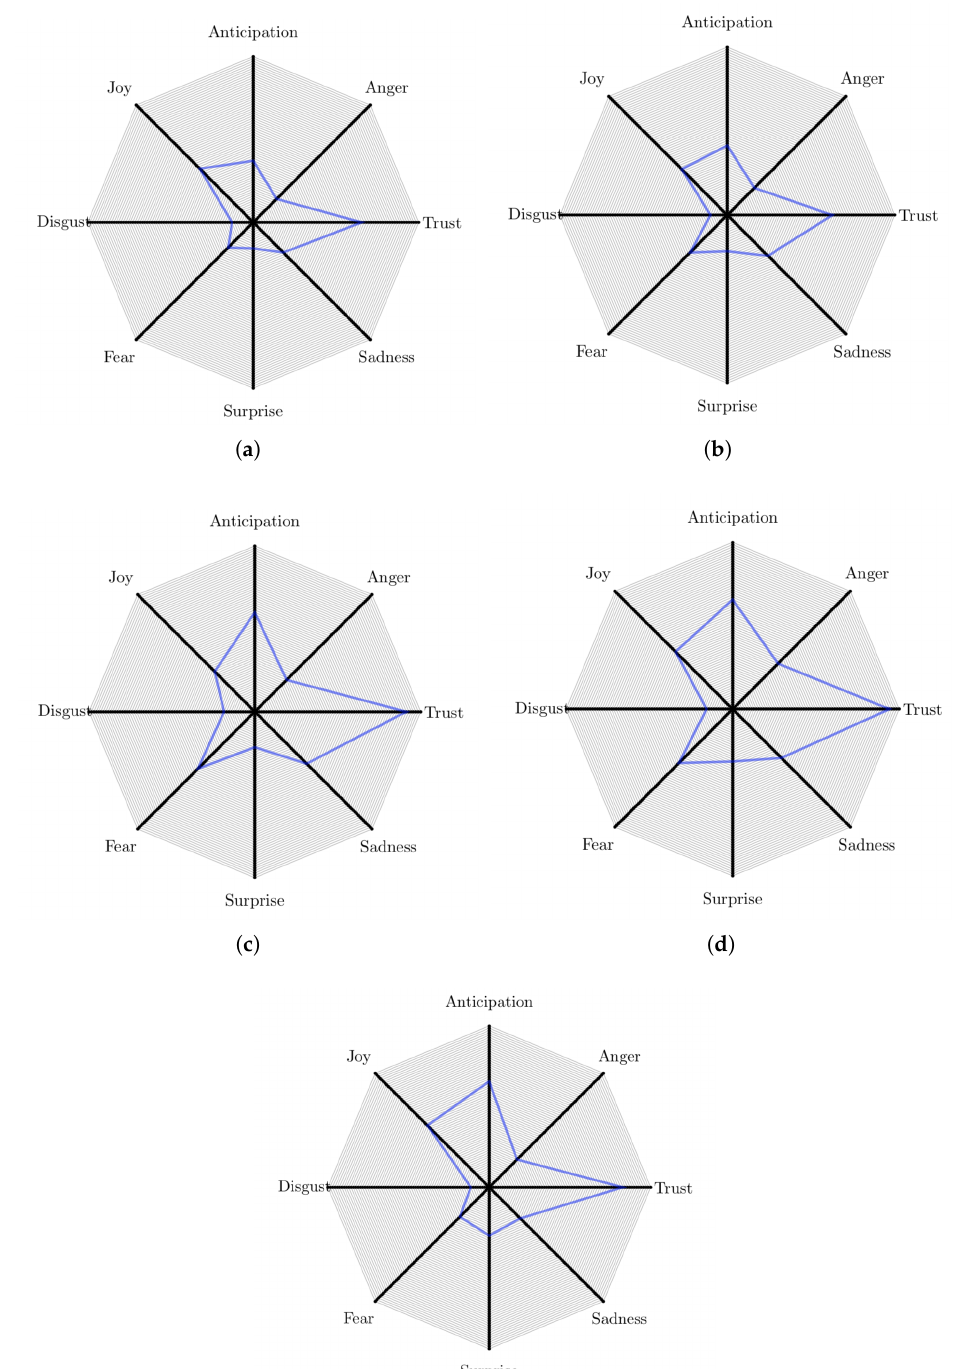
Figure 3. Mean sentiment scores. ( a ) Wealth Redistribution dataset; ( b ) Budget-Minded dataset; ( c ) Healthcare dataset; ( d ) Life Insurance dataset; ( e ) First Real Job